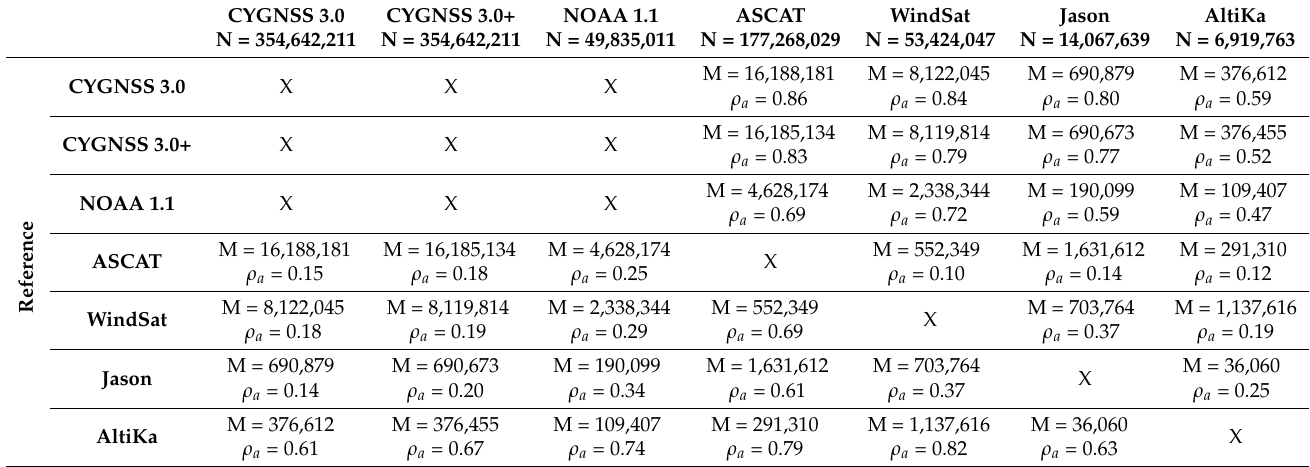
Table 4. Correlation between the wind speed difference of ECMWF wrt a reference sensor (rows) and the WS difference of another sensor (columns) wrt the same reference sensor. N is the total number of observations of a given product and M is the number of matched observations. ASCAT refers to the combined results from ASCAT-A and ASCAT-B (i.e., not to the results using a quadruple collocation). Similarly, Jason refers to the combined results from Jason-2 and Jason-3.